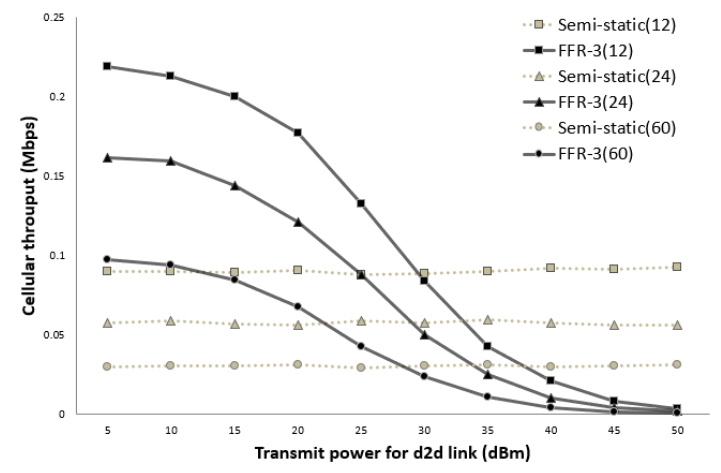
Figure 14. Cellular link throughput versus D2D transmit power (cellular Tx power = 30 dBm).